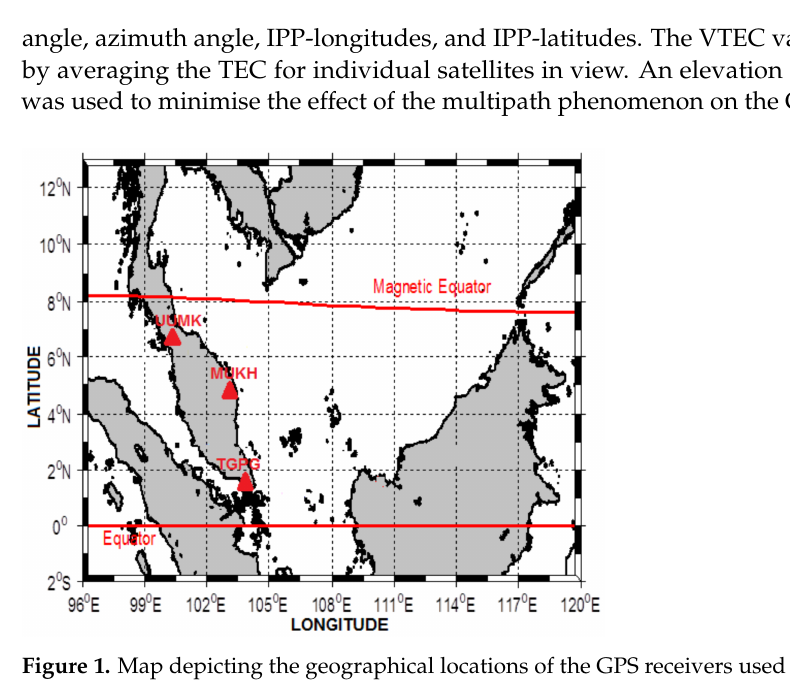
Figure 1. Map depicting the geographical locations of the GPS receivers used over UUMK, MUHK, and TGPG